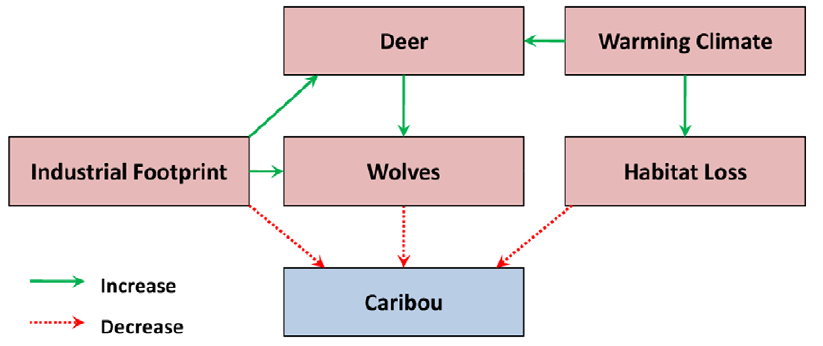
Figure 2. Impact hypothesis diagram for selected factors affecting caribou viability. doi:10.1371/journal.pone.0031672.g002 PLoS ONE |